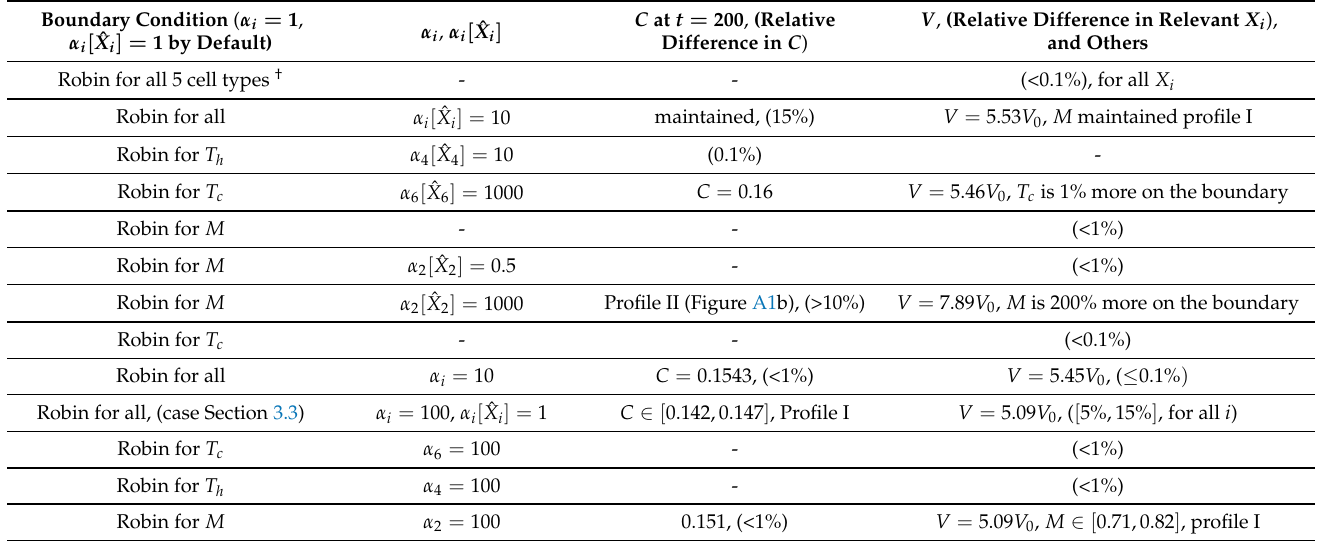
Table A4. A report of different experiments using uniform initial